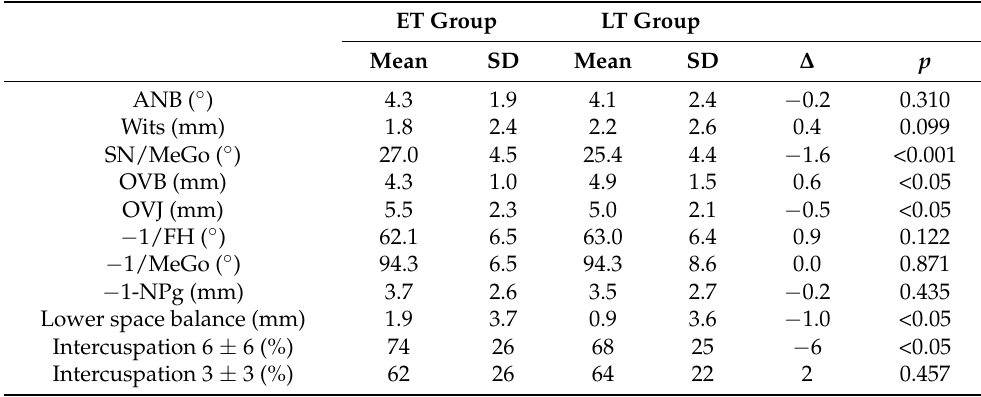
Table 1. Descriptive parameters at